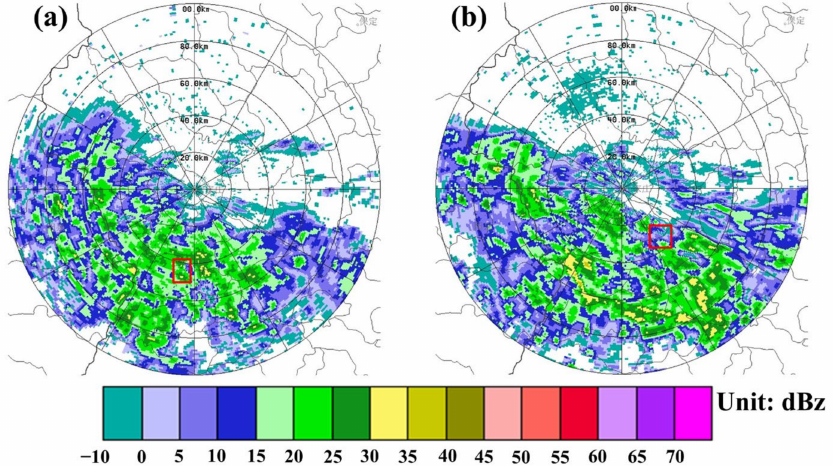
Figure 5. 24 August 2019, ( a ) 12:48, 3.4 ◦ elevation angle PPI, ( b ) 14:18, 2.4 ◦ elevation angle PPI. The red rectangle box is the aircraft detection area.